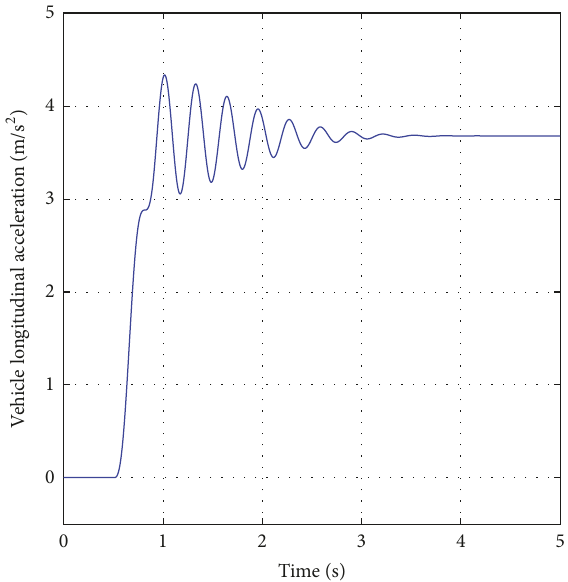
Figure 1: Vehicle response in a tip-in condition: vehicle longitudinal